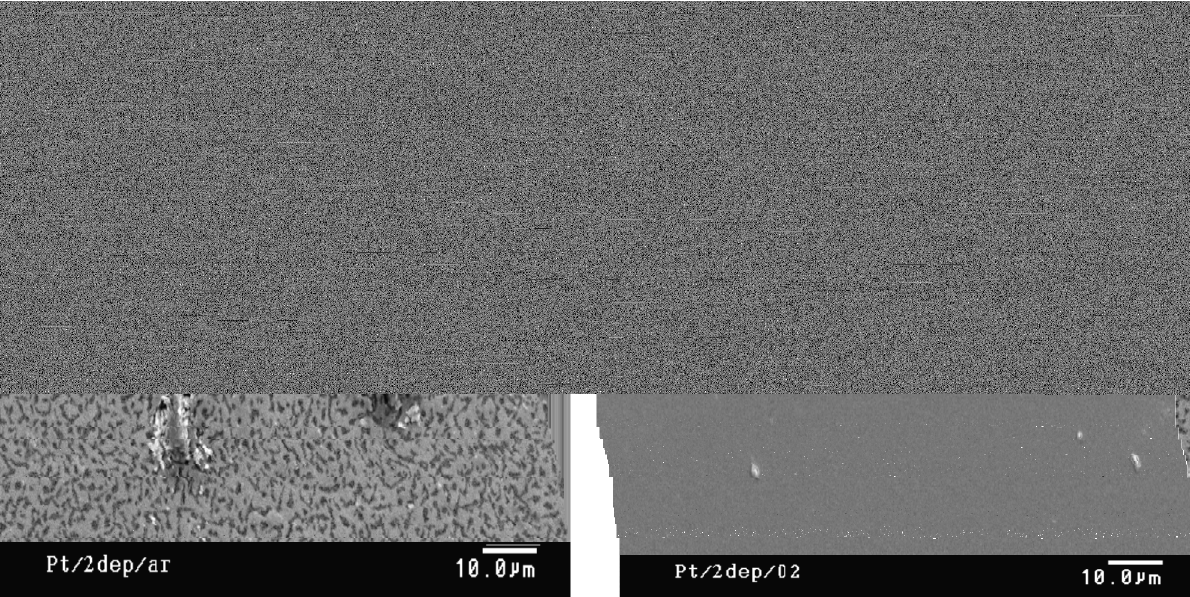
Figure 4. SEM micrographs of PLZT film surfaces ( η = 40 cP) deposited on Si/Ti/Pt (100) substrate with speed of 5 mm/min, heating rate of 5 °C/min and annealed at 650 °C for 3 h at differents atmospheres: (a) air and (b) oxygen.